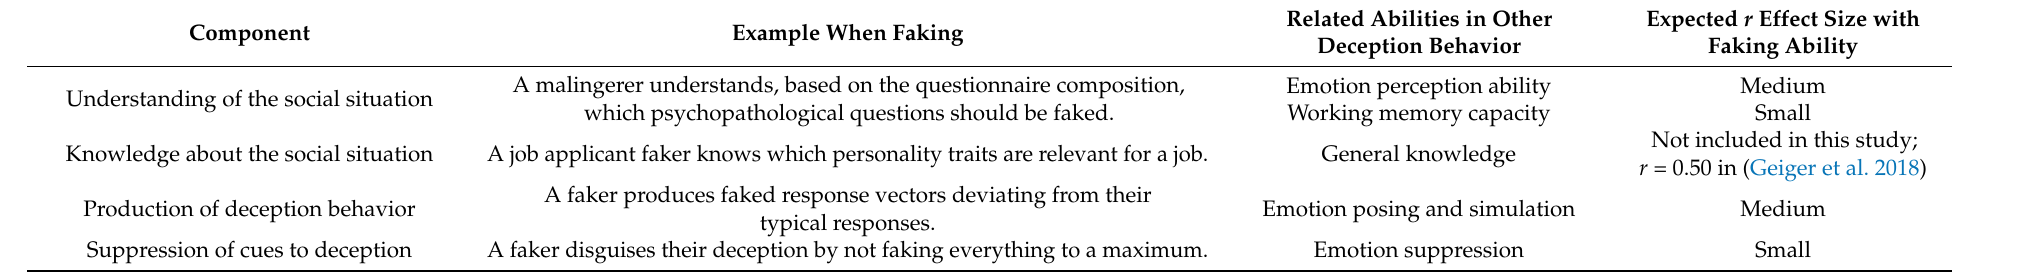
Table 1. Components of faking